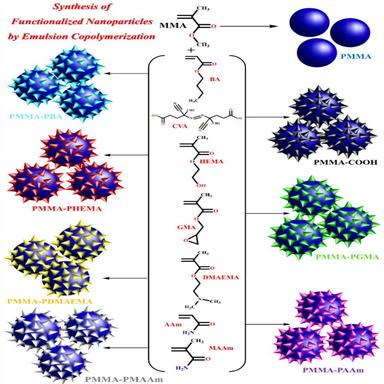
Schematic for the synthesis of multi-functionalized copolymer nanoparticles by emulsion polymerization.